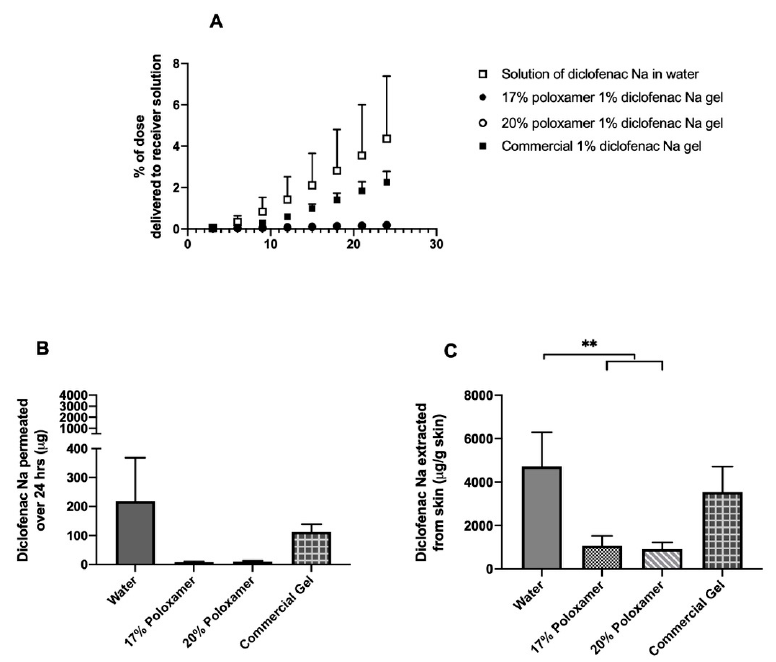
Figure 6. In vitro drug permeation study through intact porcine ear skin. ( A ) Percent of the initial 5 mg dose delivered to the receiver compartment over 24 h. ( B ) Total mass of diclofenac sodium delivered to the receiver compartment over 24 h. ( C ) Total mass of diclofenac sodium extracted per gram of skin upon completion of 24-h permeation study. Data presented as mean ± SD ( n = 3 for all treatment conditions except solution in water, for which n = 6). ** p ≤ 0.01.